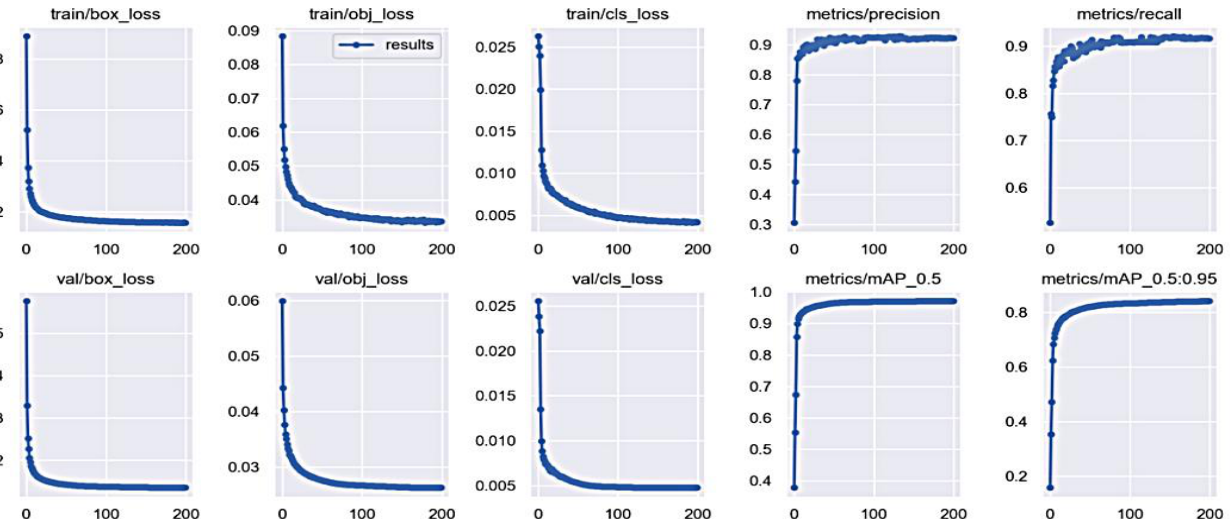
√ ” represents that the improved method is Model mAP mAP.5:.95 FLOPs Parameters Size (%) (%) (G)